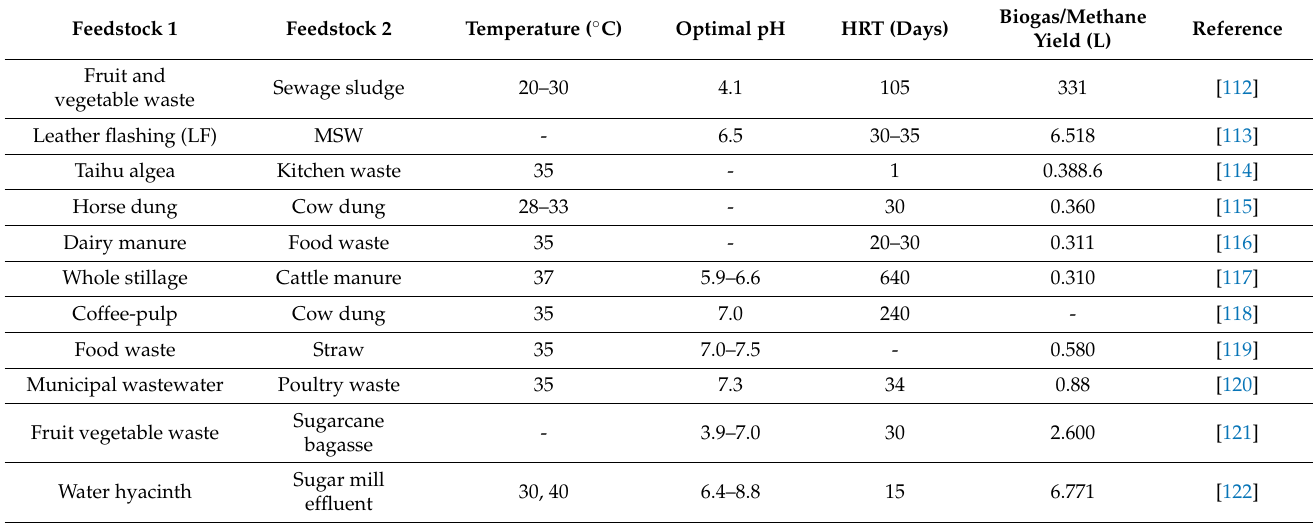
Table 1. Previously reported studies on biogas and methane production through a co-digestion of different types of feedstocks at diverse operating